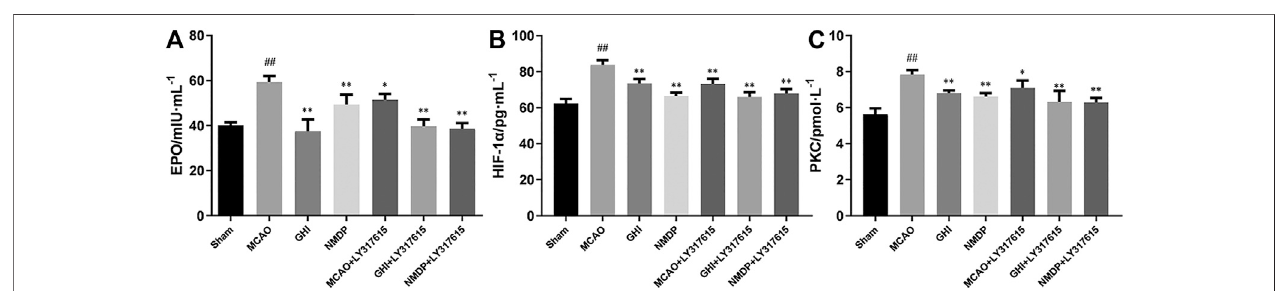
FIGURE 6 | The expression of EPO (A) , HIF-1 α (B) and PKC (C) in rat after I/R for each group ( x ± SD, n (cid:1) 6). #, compared with the Sham group; *, compared with the MCAO group; “ ## ” and “ ** ” means that the p value is less than 0.01; “ # ” and “ * ” means that the p value is less than 0.05.